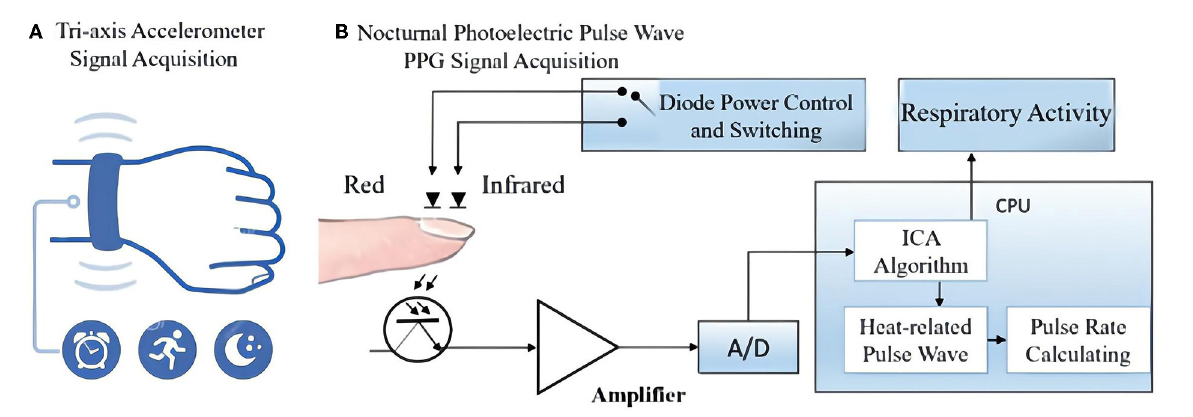
FIGURE1 System setup: The data collection and analysis of wrist-wearable sensors. (A) The built-in tri-axial accelerometer records the acceleration signal of the wrist and converts it into a digital signal for storage; (B) two channels of transmission mode PPG signals were collected from the participants’ index finger and analyzed using an independent component analysis (ICA) algorithm. The respiratory activity was separated from the heart-related pulsation in PPG after the ICA analysis.